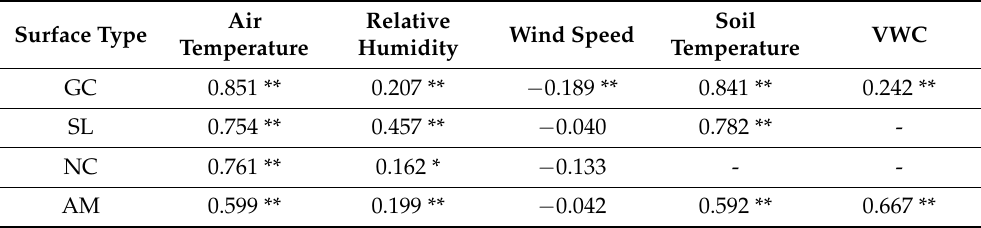
Table 2. Correlation between actual evapotranspiration and different meteorological factors at the four observation stations in The Qaidam Basin.